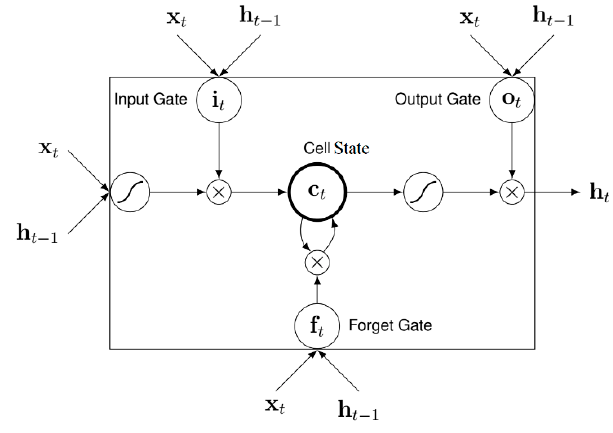
Figure 1. Internal structure of a simple long short-term memory (LSTM) unit.